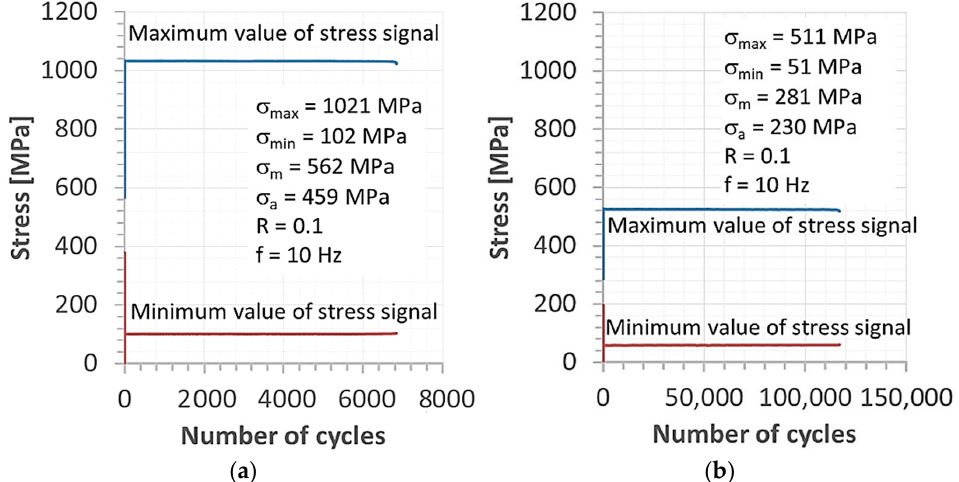
Figure 2. Levels of maximum and minimum values of stress signal versus the number of cycles used to control the testing machine for the fatigue process: ( a ) at high and ( b ) low-stress